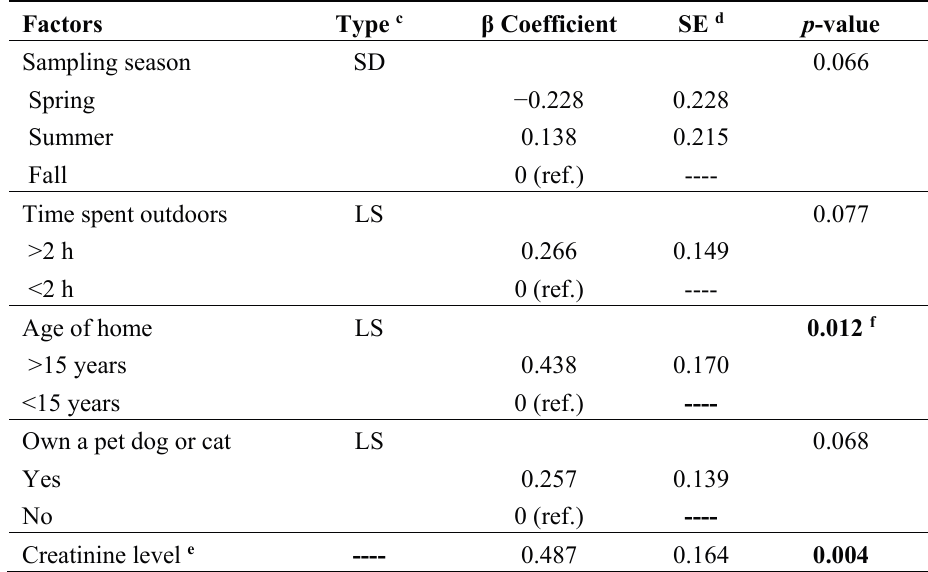
Table 4. Final reduced regression model of factors influencing ln urinary PCP levels in children a,b